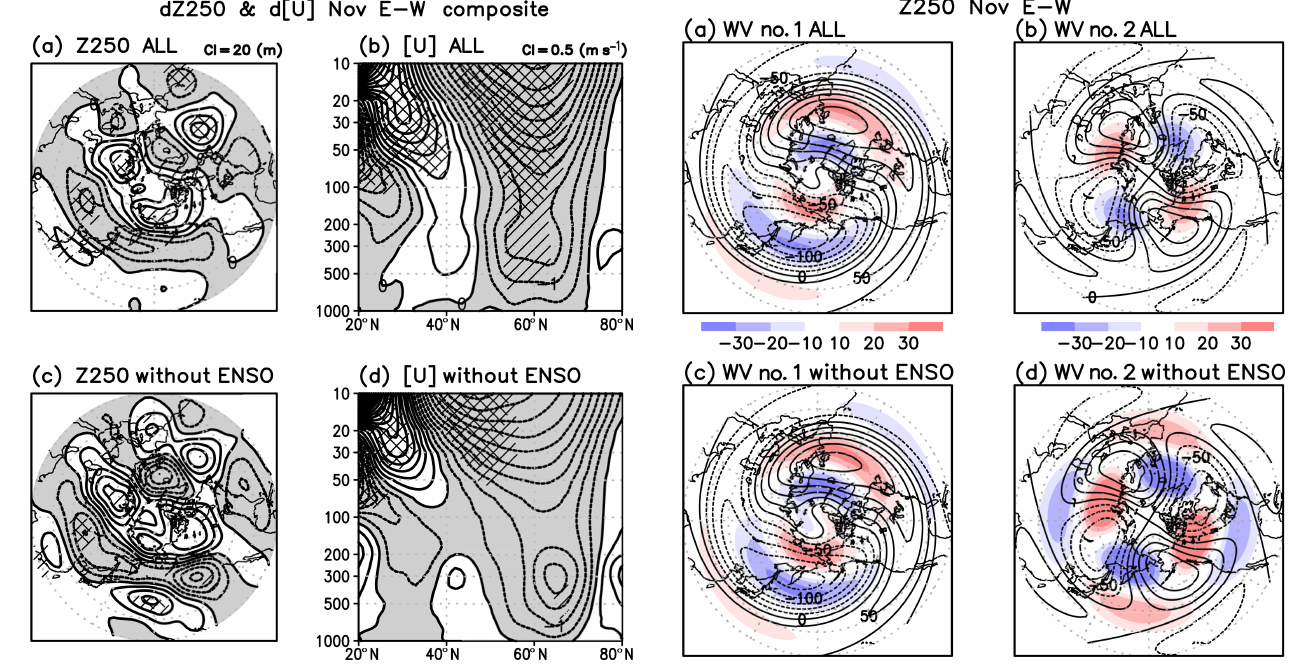
Figure 7. (a) Composite difference of geopotential height at 250hPa (Z250) in November between EQBO and WQBO winters. Contour interval (CI) is 20m and negative values are shaded. The values statistically significant at 90% and 95% level are hatched. (b) Same as panel (a) but for the zonal-mean zonal wind (CI of 0.5ms − 1 ). (c) Same as panel (a) but without ENSO winters. (d) Same as panel (b) but without ENSO winters.